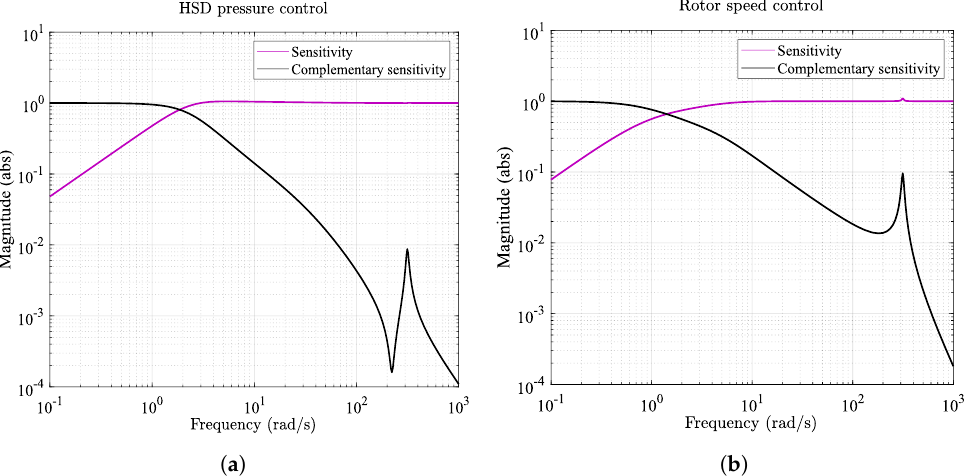
Figure 11. Closed-loop frequency response of HSD pressure and rotor speed control. ( a ) Frequency response of the plant G 11 ( s ) . ( b ) Frequency response of the plant G 22 ( s )